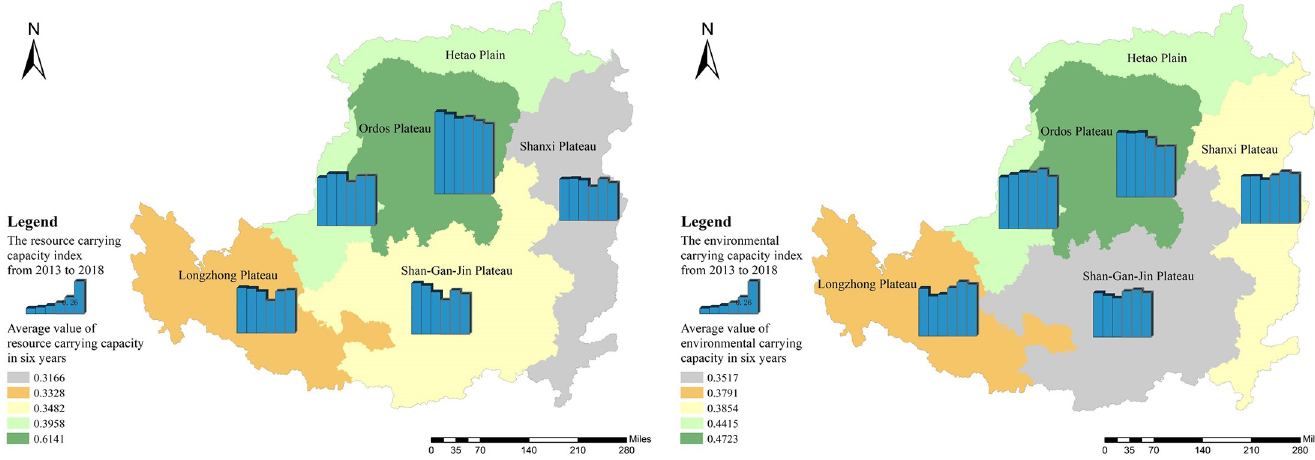
Fig 9. Temporal and spatial pattern of carrying capacity (left: resource carrying capacity; right: environmental carrying capacity). The image was obtained by using ArcGIS 10.2 through the open-access data process. The spatial extent of the Loess Plateau was obtained from the Resource and Environmental Science Data Center of the Chinese Academy of Sciences (http://www.resdc.cn/).